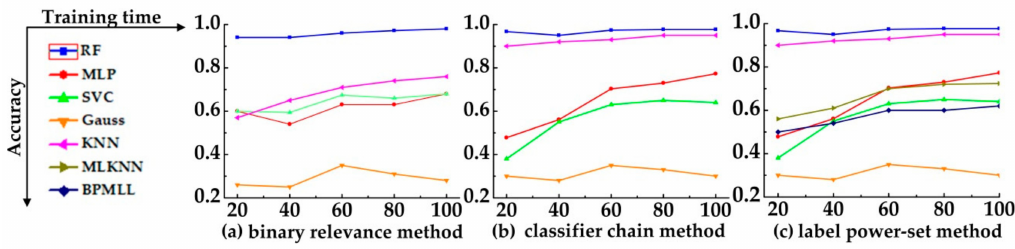
Figure 10. The identify accuracy of each multi-label classification